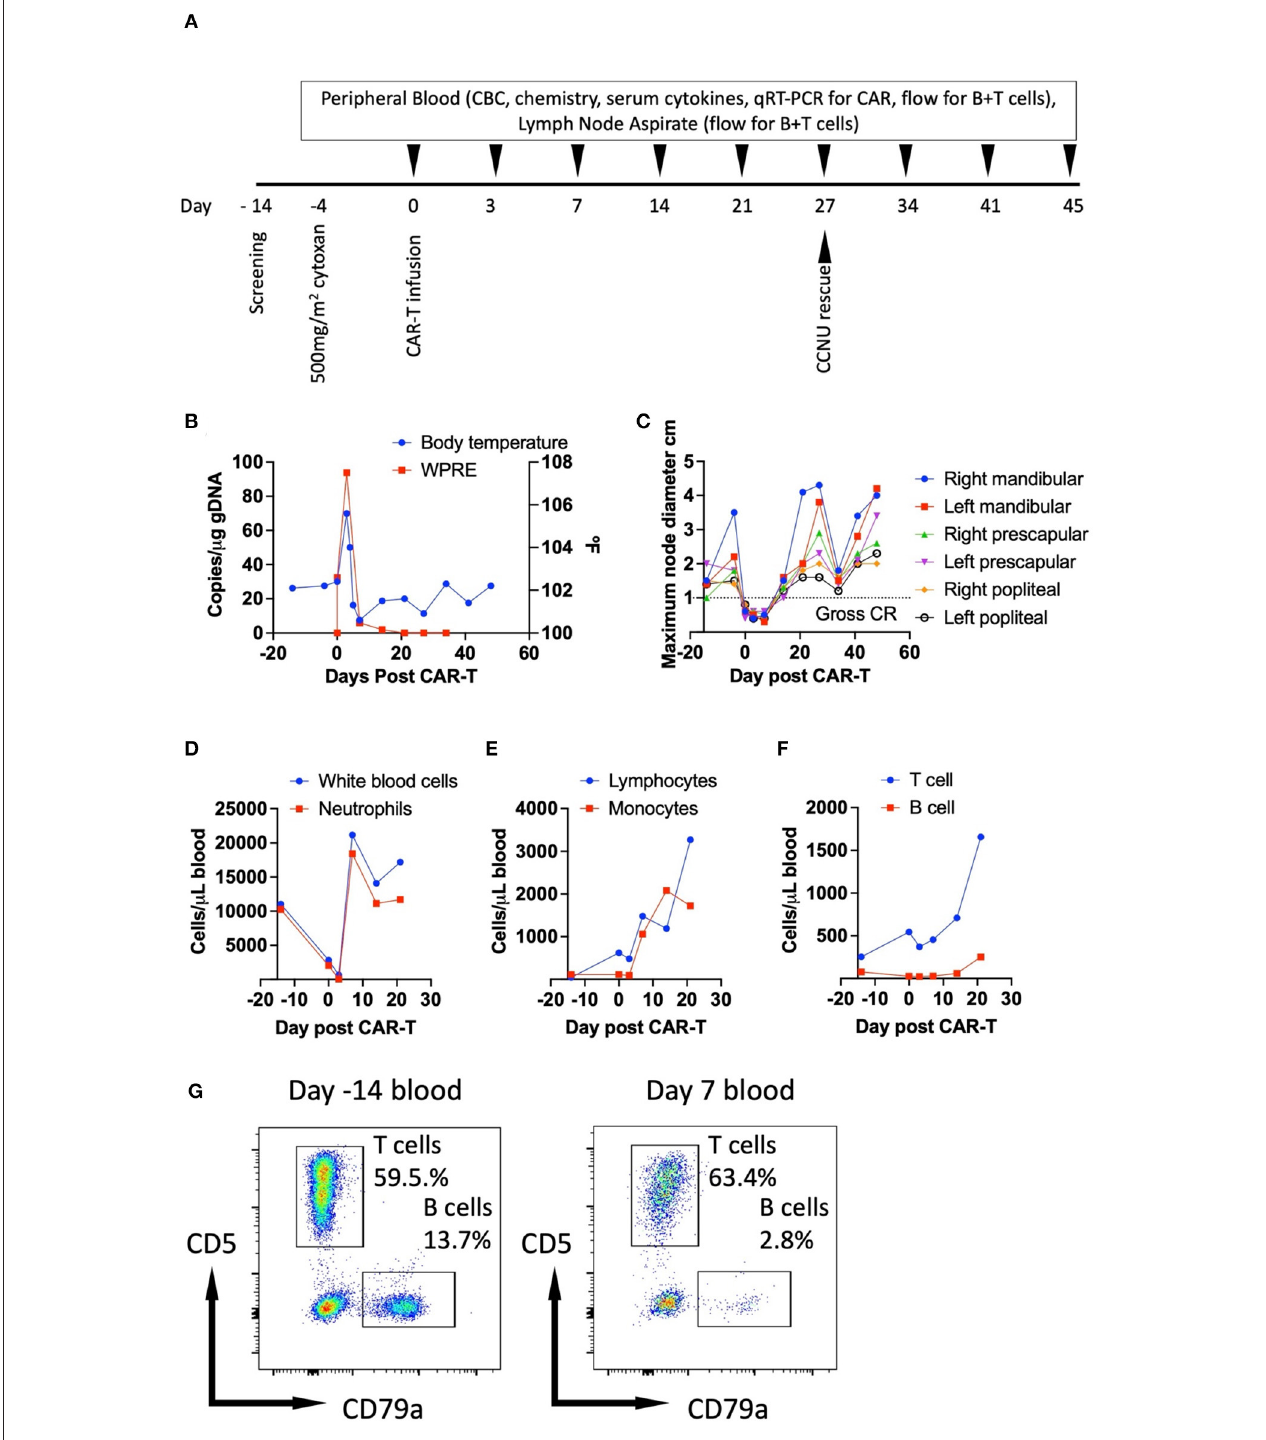
FIGURE 3 | Clinical summary of patient’s response to CAR-T therapy. Therapeutic timeline (A) ; monitoring of body temperature and in vivo CAR-T cell levels (B) ; tracking of target node dimensions (C) ; circulating white blood cell and neutrophil counts (D) ; circulating lymphocyte and monocyte counts (E) ; tracking of circulating T and B cell counts determined by the product of the frequencies CD5 + or CD79a + live cells in the lymphogate quantified flow cytometrically, and the number of circulating lymphocytes obtained by complete blood count (F) and flow cytometry performed on PBMCs stained for CD5-PE and CD79a-APC at day − 14 and day 7 post-CAR-T (G) . WPRE- woodchuck hepatitis virus post-transcriptional regulatory element, used for detection of genomic copies of CAR by qRT-PCR as previously described (6); CR- complete response.